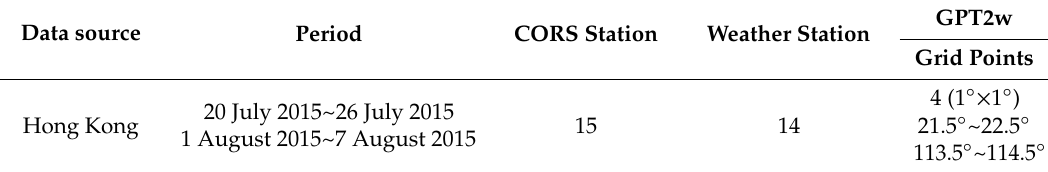
Table 1. Multisource Data for the troposphere fusion